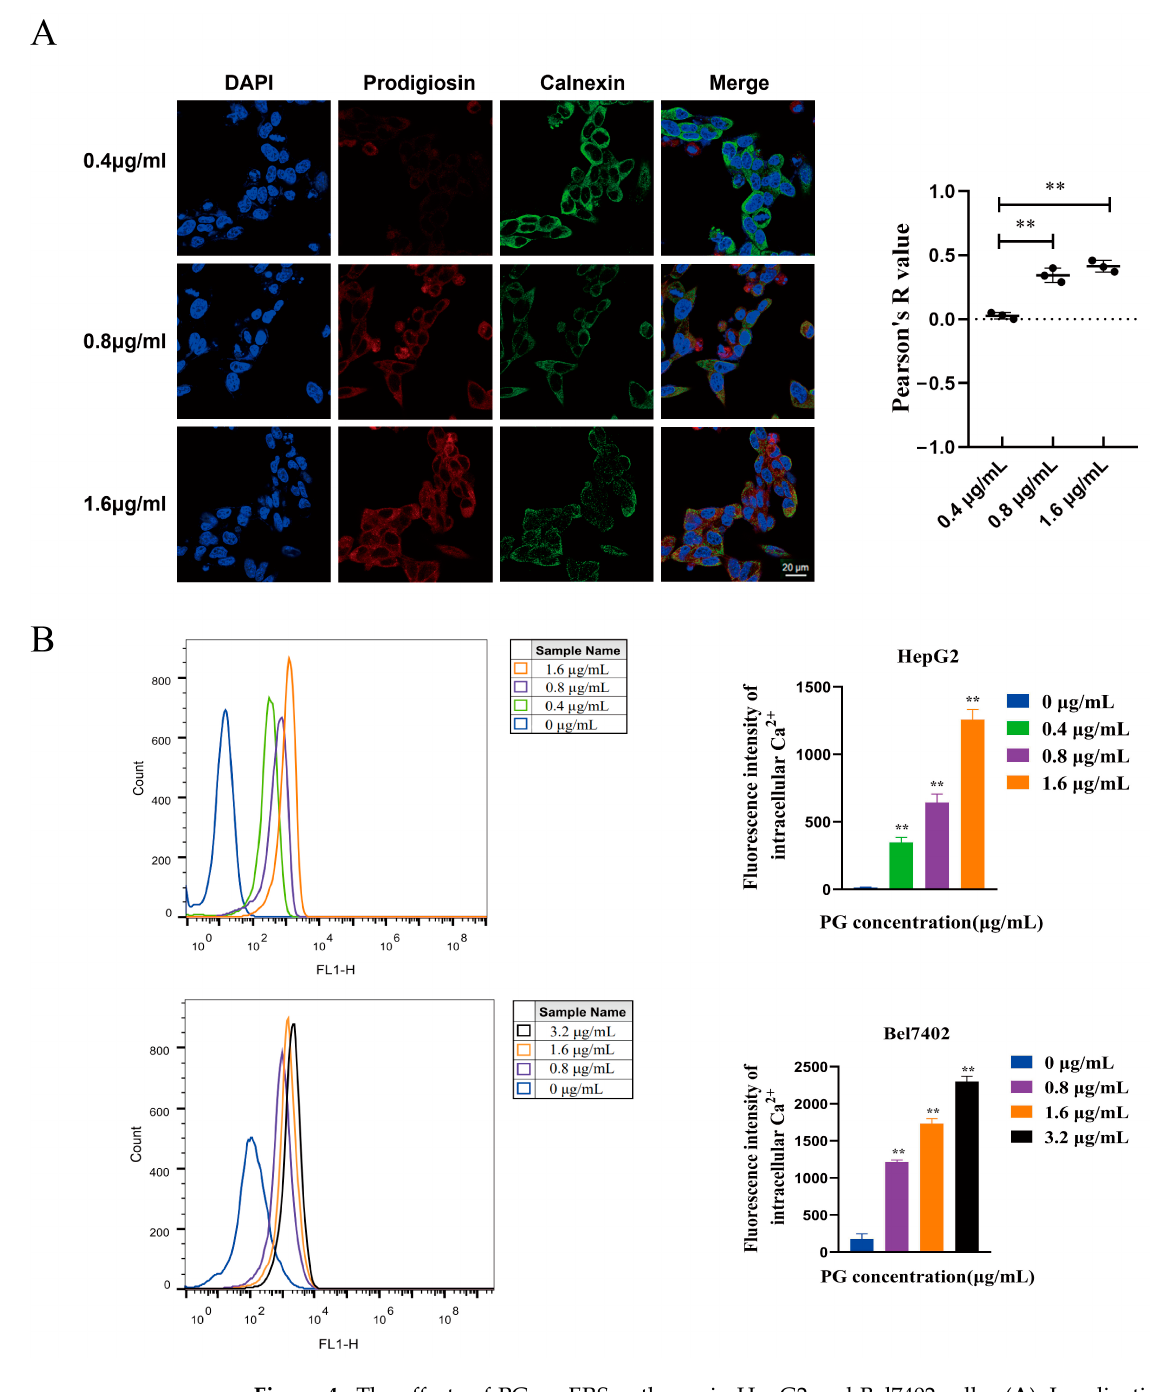
Figure 4. The effects of PG on ERS pathway in HepG2 and Bel7402 cells. ( A ). Localization of PG in HepG2 cells as observed under confocal laser fluorescence microscopy; ( B ). Flow cytometry for the effect of PG on Ca 2+ concentration in HepG2 and Bel7402 cells. The treatments included PG (0.4 µ g/mL, 0.8 µ g/mL, 1.6 µ g/mL, 3.2 µ g/mL) vs. 0 µ g/mL of PG, ** p < 0.01, n =